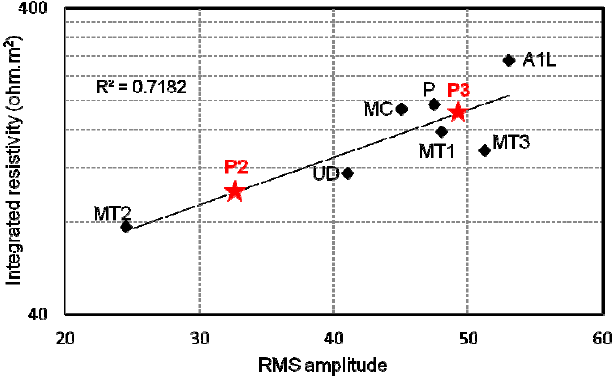
Figure 7. Cross-plot between the integrated resistivity for the upper unit (Unit IV-1 and Unit IV-2) and the RMS amplitude for the top of the MHCZ at each location using the existing seven wells.